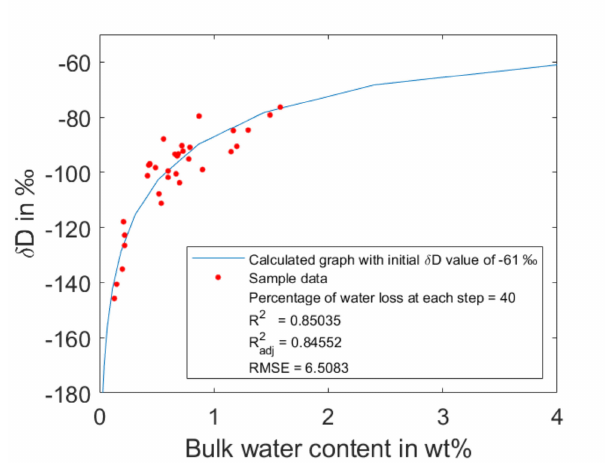
Figure 6: Modeled, best-fit, single staged batched- system trend with variable step size for the 2008 Chaitén eruption products. Simulations performed at an assumed eruption temperature of 800 ˝ C [Castro and Dingwell 2009]. Data from Castro et al. [2014] are shown as red dots. Here each step invokes